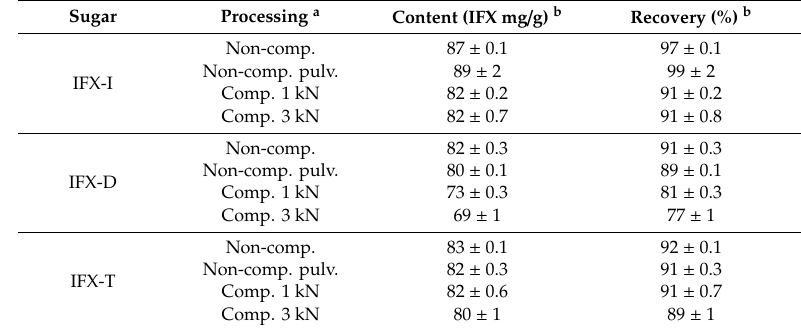
Table 3. The average ± SD ( n = 2) IFX recovery from the different IFX-sugar glass compacts.